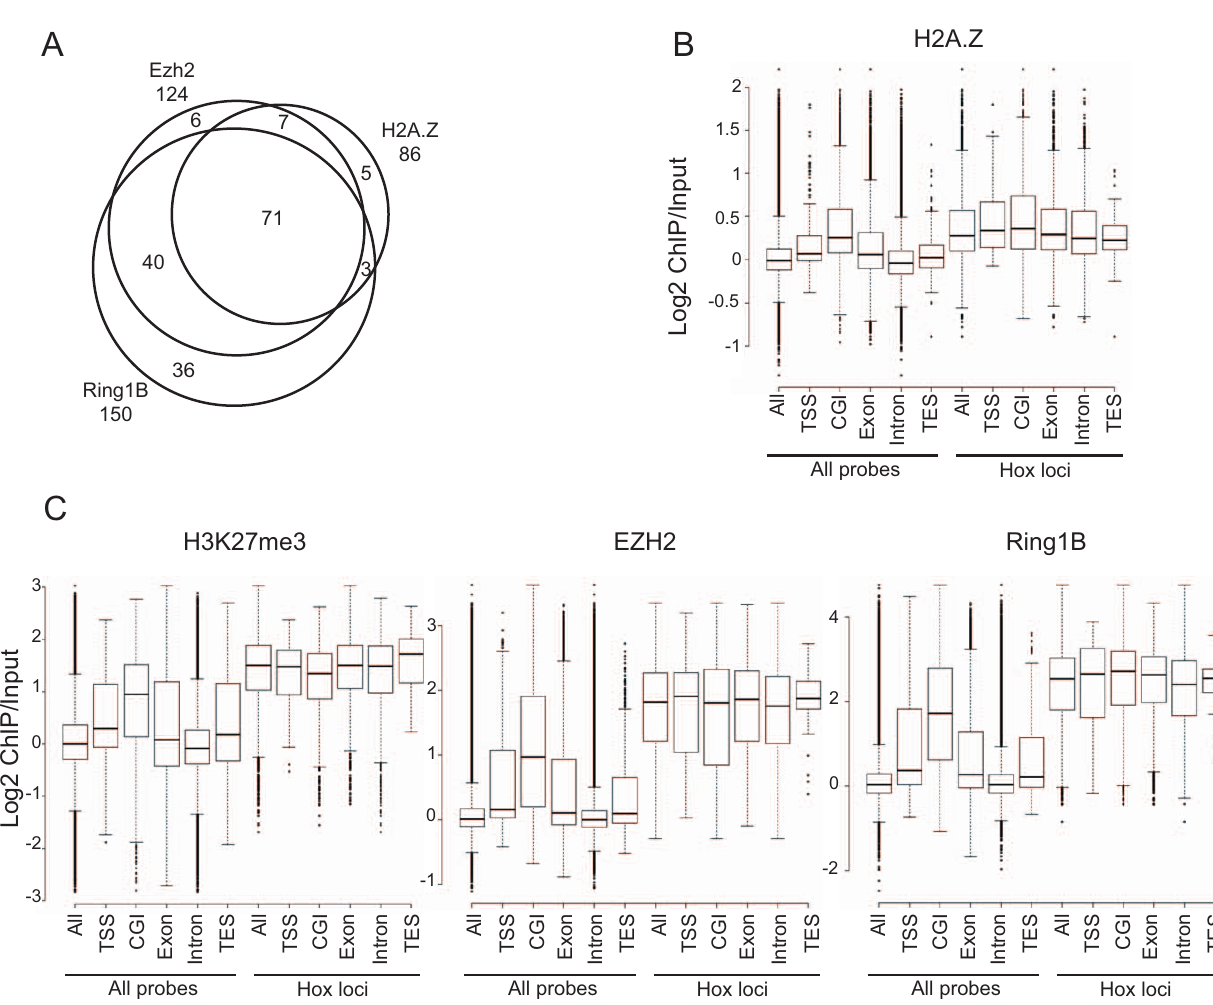
Figure 8. H2A.Z localises to CpG islands and overlap with EZH2 and Ring1B. A) Venn diagram showing overlap of genes displaying H2A.Z with EZH2 and Ring1B enrichment at TSS 6 500 bp within arrayed regions (total 240 unique TSS) in WT ESCs. B) Box plots showing Log2 H2A.Z ChIP/ Input of over TSSs ( 6 250 bp), CpG islands (CGI), exons, introns and transcription end sites (TES 6 250 bp) across all probes or Hox loci in WT ESCs. C) As in (E) but for EZH2, H3K27me3 and